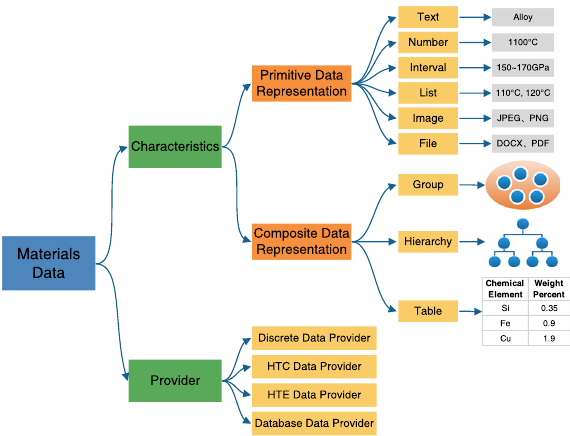
Fig. 6 Characteristics and provider classi fi cation of materials data. From the point of view of the characteristics of materials data, they can be characterized by primitive data representation forms and composite data representation forms. From another point of view of providers of materials data, they can be classi fi ed into four types based on the regularity of datasets stored in